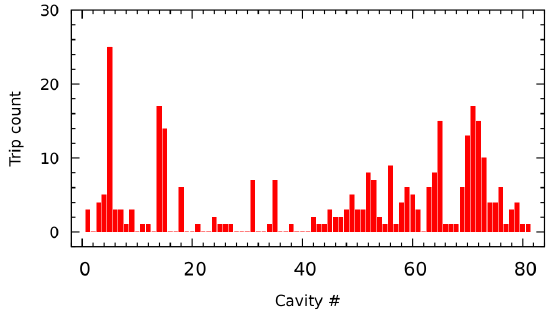
FIG. 8. Numbers of trips of the individual SRF cavities in